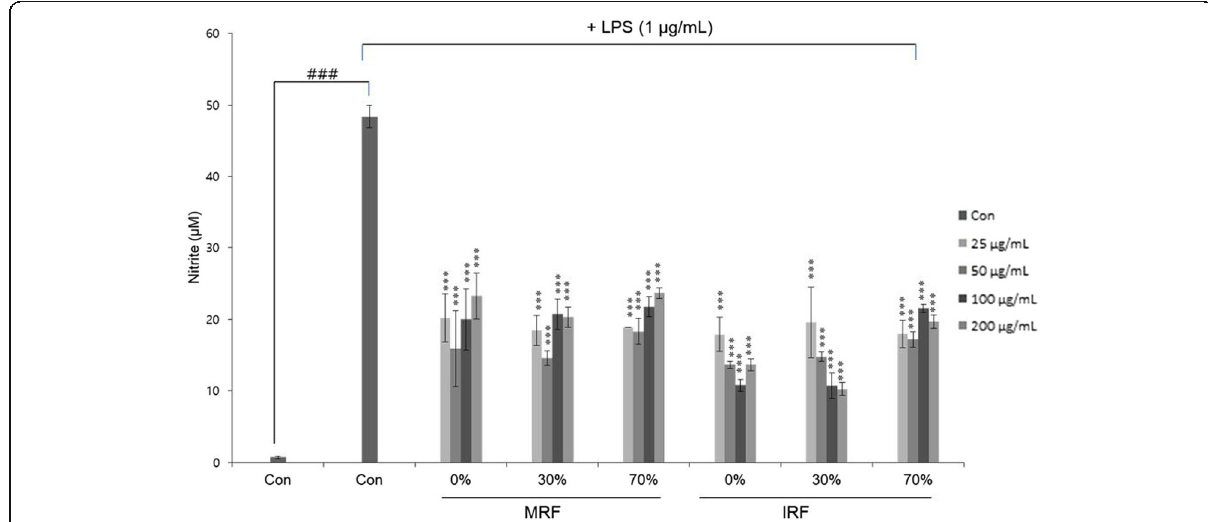
Fig. 2 Effects of Rubus coreanus fruit (RF) extracts on nitric oxide (NO) production of lipopolysaccharide (LPS)-induced RAW264.7 cells. Cells were pretreated with various concentrations of mature RF (MRF) and immature RF (IRF; 25, 50, 100, and 200 μ g/mL) for 1 h, followed by 1 μ g/mL LPS for 18 h. NO production was measured using Griess reagent. All values are means ± SD, n = 3. . ### p < 0.001, comparing control and LPS control. *** p < 0.001, comparing LPS control and each